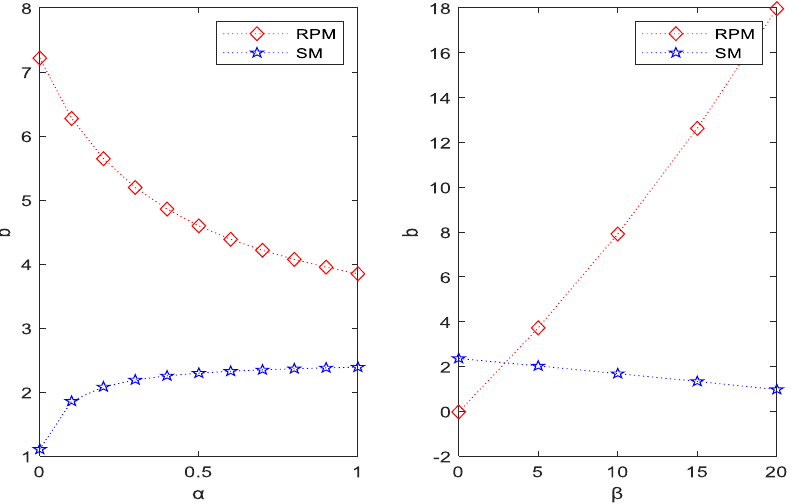
Figure 6. Buyback price under RPM and SM vs. fixed cost coefficient ( left ) and environmental benefit coefficient ( right ).